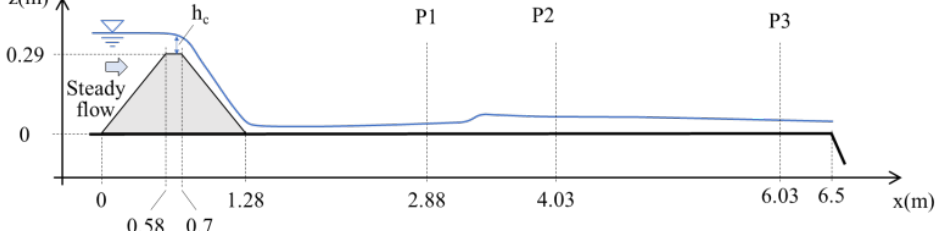
Figure 1. Schematic diagram of the experimental setup against a steady flow in Case E (wave gauges were set at P1 – P3).